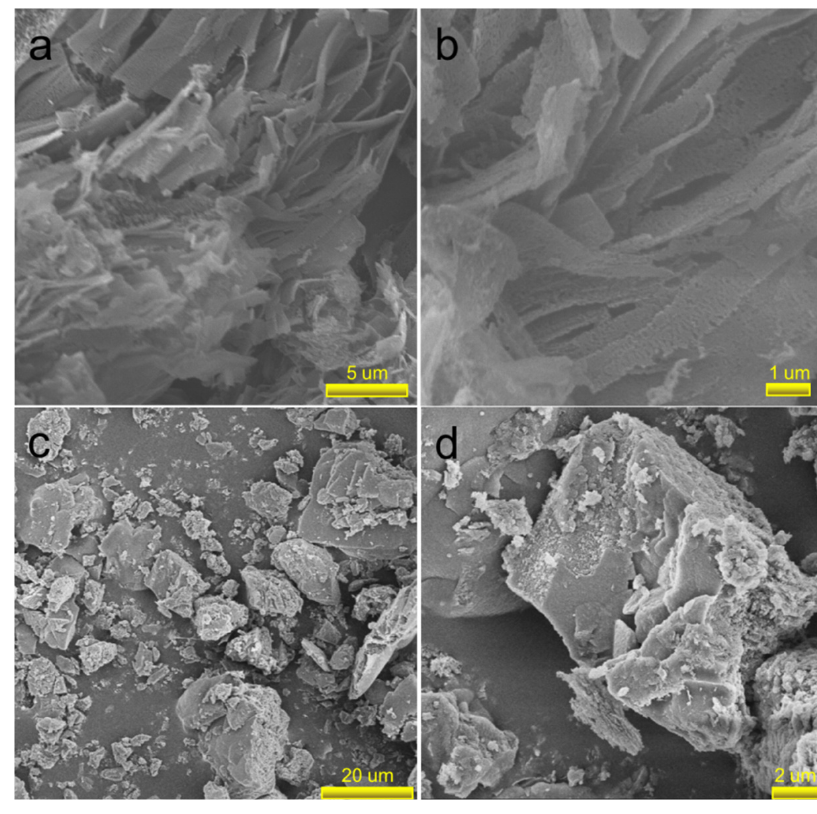
Figure 2. SEM images of PN-g-C 3 N 4 ( a , b ) and g-C 3 N 4 ( c , d ) samples.